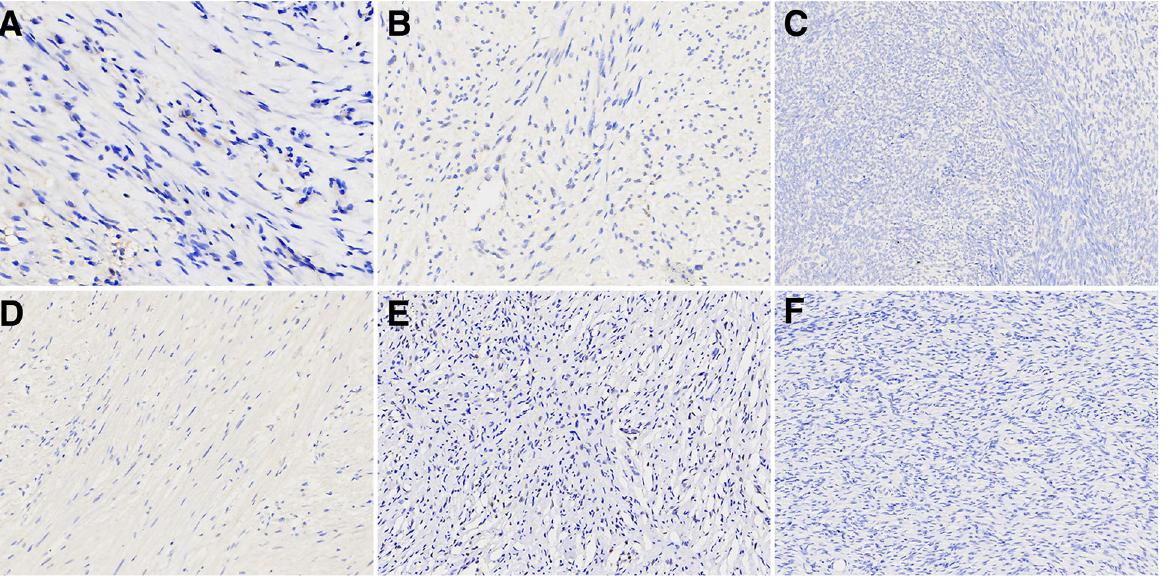
Fig. 4 TFE3 expression in other fibroblastic and myofibroblastic lesions and spindle cell tumors. NF exhibited TFE3 negative expression ( a , 400×), GIST showed TFE3 negative expression ( b , 400×), while synovial sarcoma ( c , 400×), leiomyoma ( d , 400×), neurofibroma ( e , 400×), and DFSP ( f , 400×) were all negative for